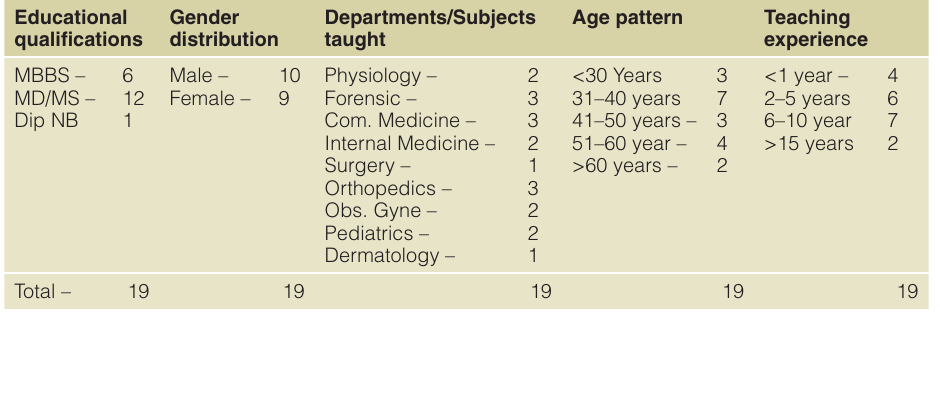
Table 2. Showing the self-perception of improvement in mean awareness by participants at different times after training. Time of assessment Immediately after training n-(19)